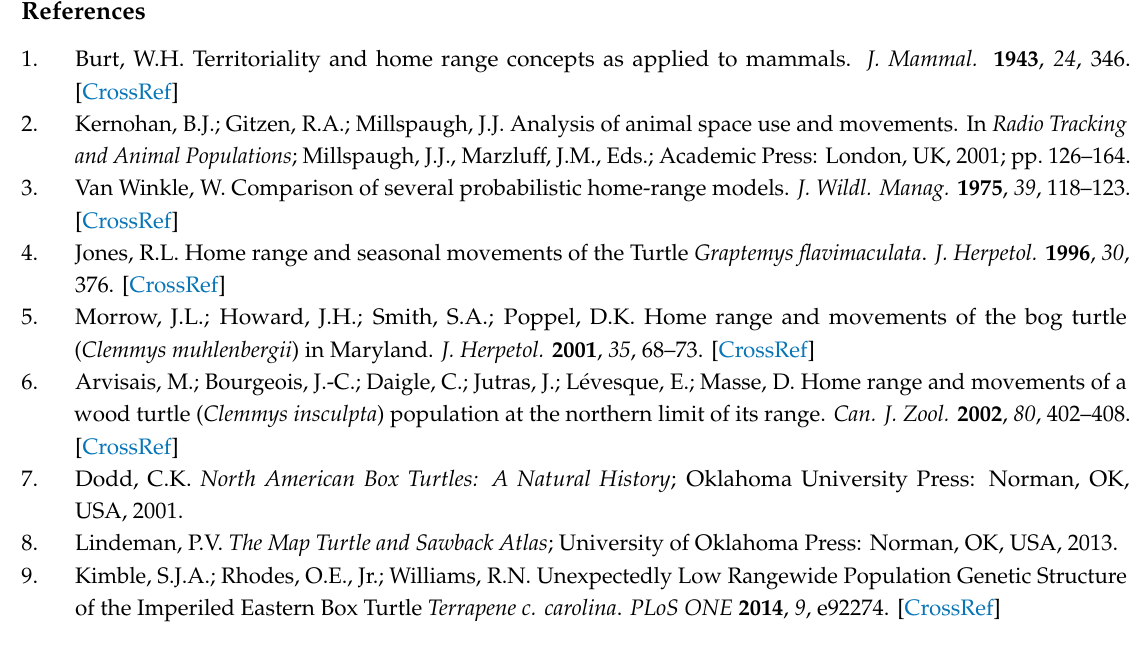
Table S1: Turtle meta-analysis data and